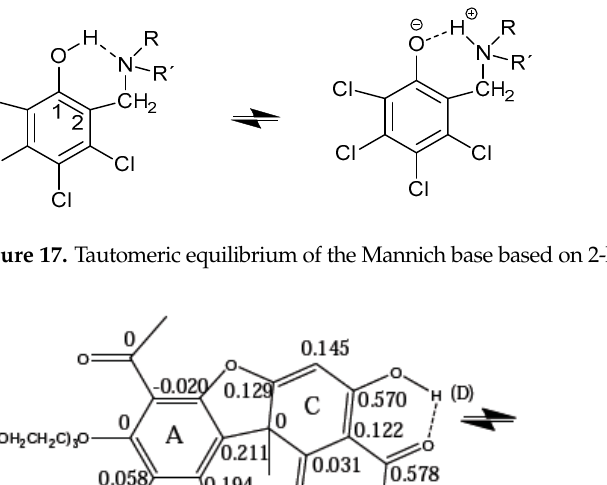
Figure 18. Deuterium isotope effects on 13 C chemical shifts of a pegylated usnic acid. From Ref. [48].